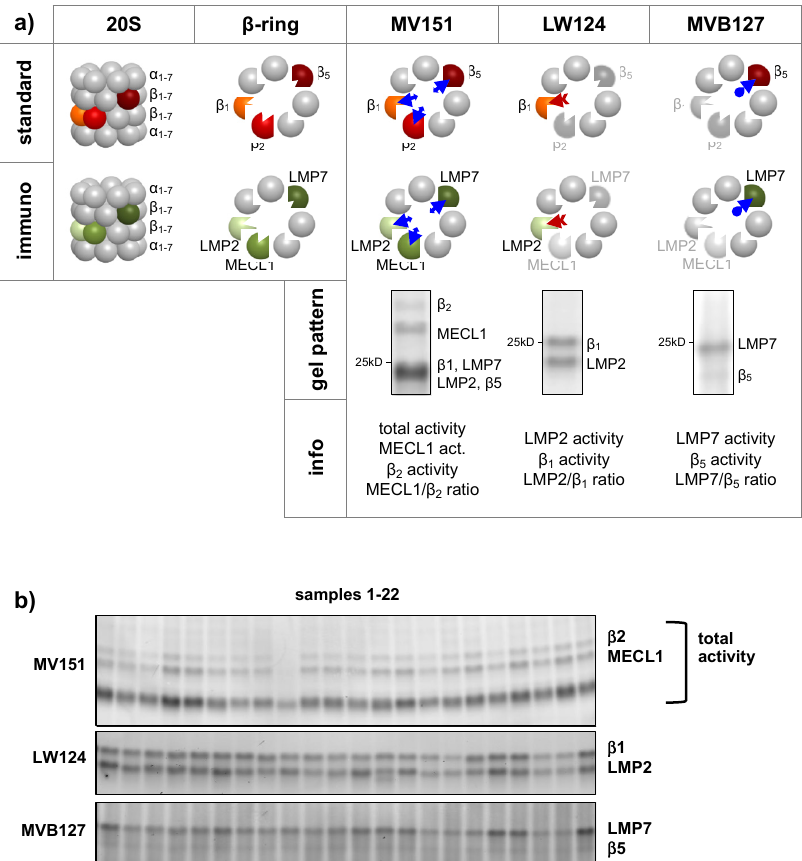
Figure 1. Proteasome activity profiling in peripheral blood mononuclear cells using activity-based probes (ABPs). ( a ) The 20S core particle of the proteasome is composed of four rings consisting of seven subunits each with dyad symmetry. The outer two α -rings control the opening of the gate and attachment to regulatory particles, while the inner two β -rings each comprise three different proteolytically active β -subunits: β 1, β 2, and β 5 for the standard proteasome (present in every cell type). The immunosubunits LMP2, MECL1, and LMP7 are mainly found in lymphoid cells. With a set of three different ABPs, which bind to and fluorescently label the active centers, the six different β -subunits can be distinguished, see lower panel of the figure. MV151 labels all six proteasome subunits, and can be used for total proteasome activity assessment, but additionally MECL1 and β 2 can be analyzed individually. LW124 labels LMP2 and β 1, while MVB127 labels LMP7 and β 5. The latter two have different fluorescent labels (here denoted in red and blue) and can be used simultaneously. For all three ABPs, the ratio of immunoproteasome subunit and their standard proteasome counterpart can also be determined. ( b ) Representative gel loaded with samples from 22 study participants and analyzed using the three activity-based probes MV151 to detect β 2, MECL1 and total activities, LW124 to discriminate β 1 and LMP2, and MVB127 to quantify β 5 and LMP7